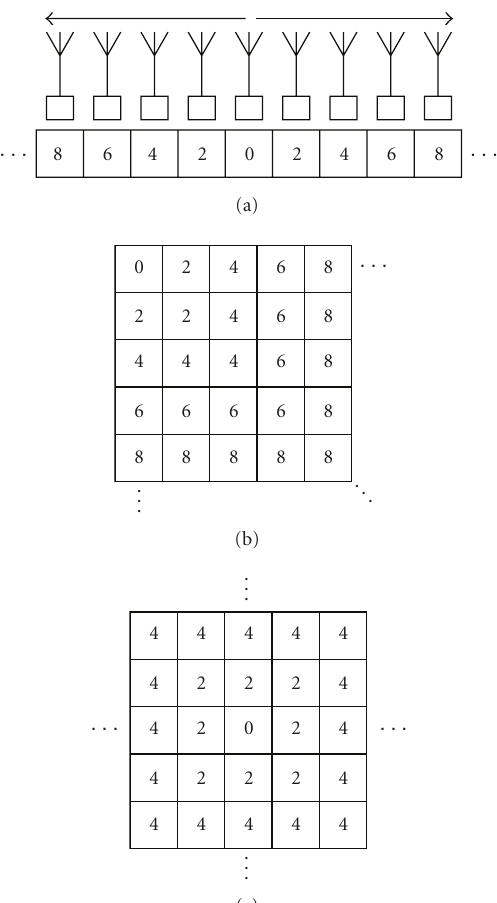
Figure 6: Calibration paths through (a) the linear array. Also the square array starting from (b) the top left and (c) the centre of the